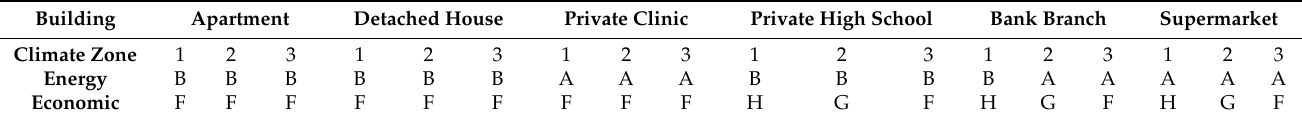
Table 9. Summary of the best solution of windows for the Portuguese